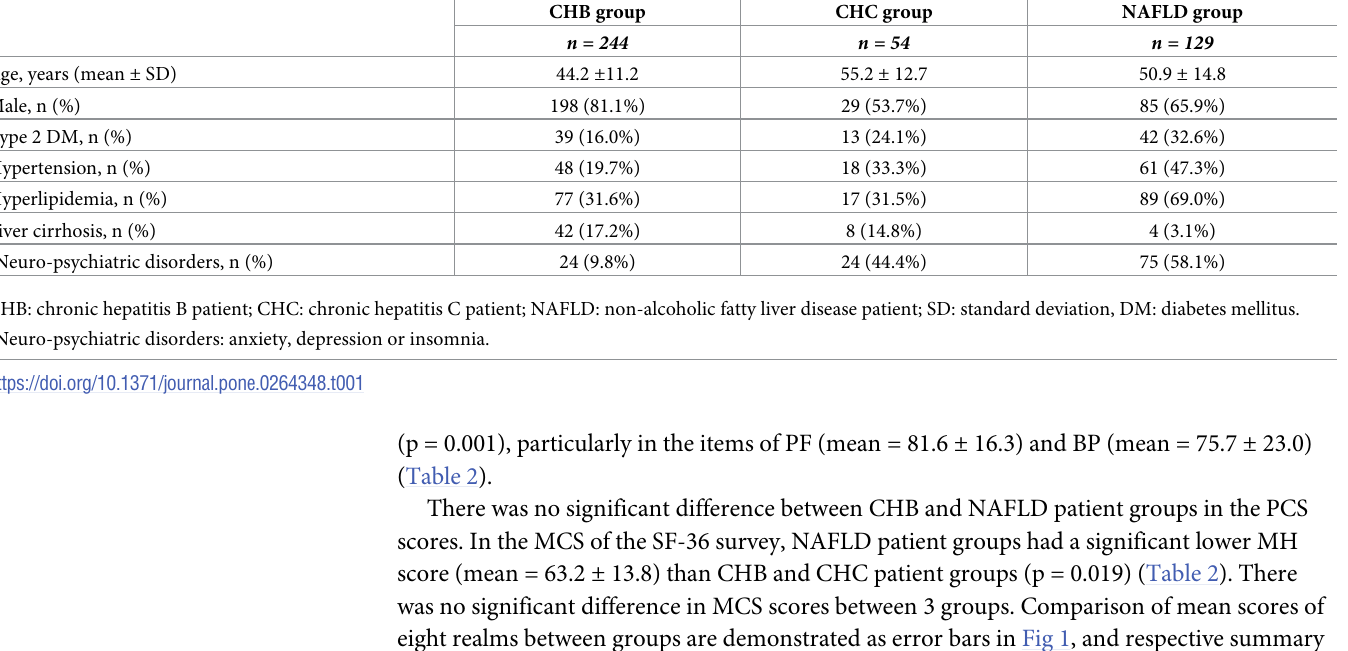
Table 1. Demographic characteristics.